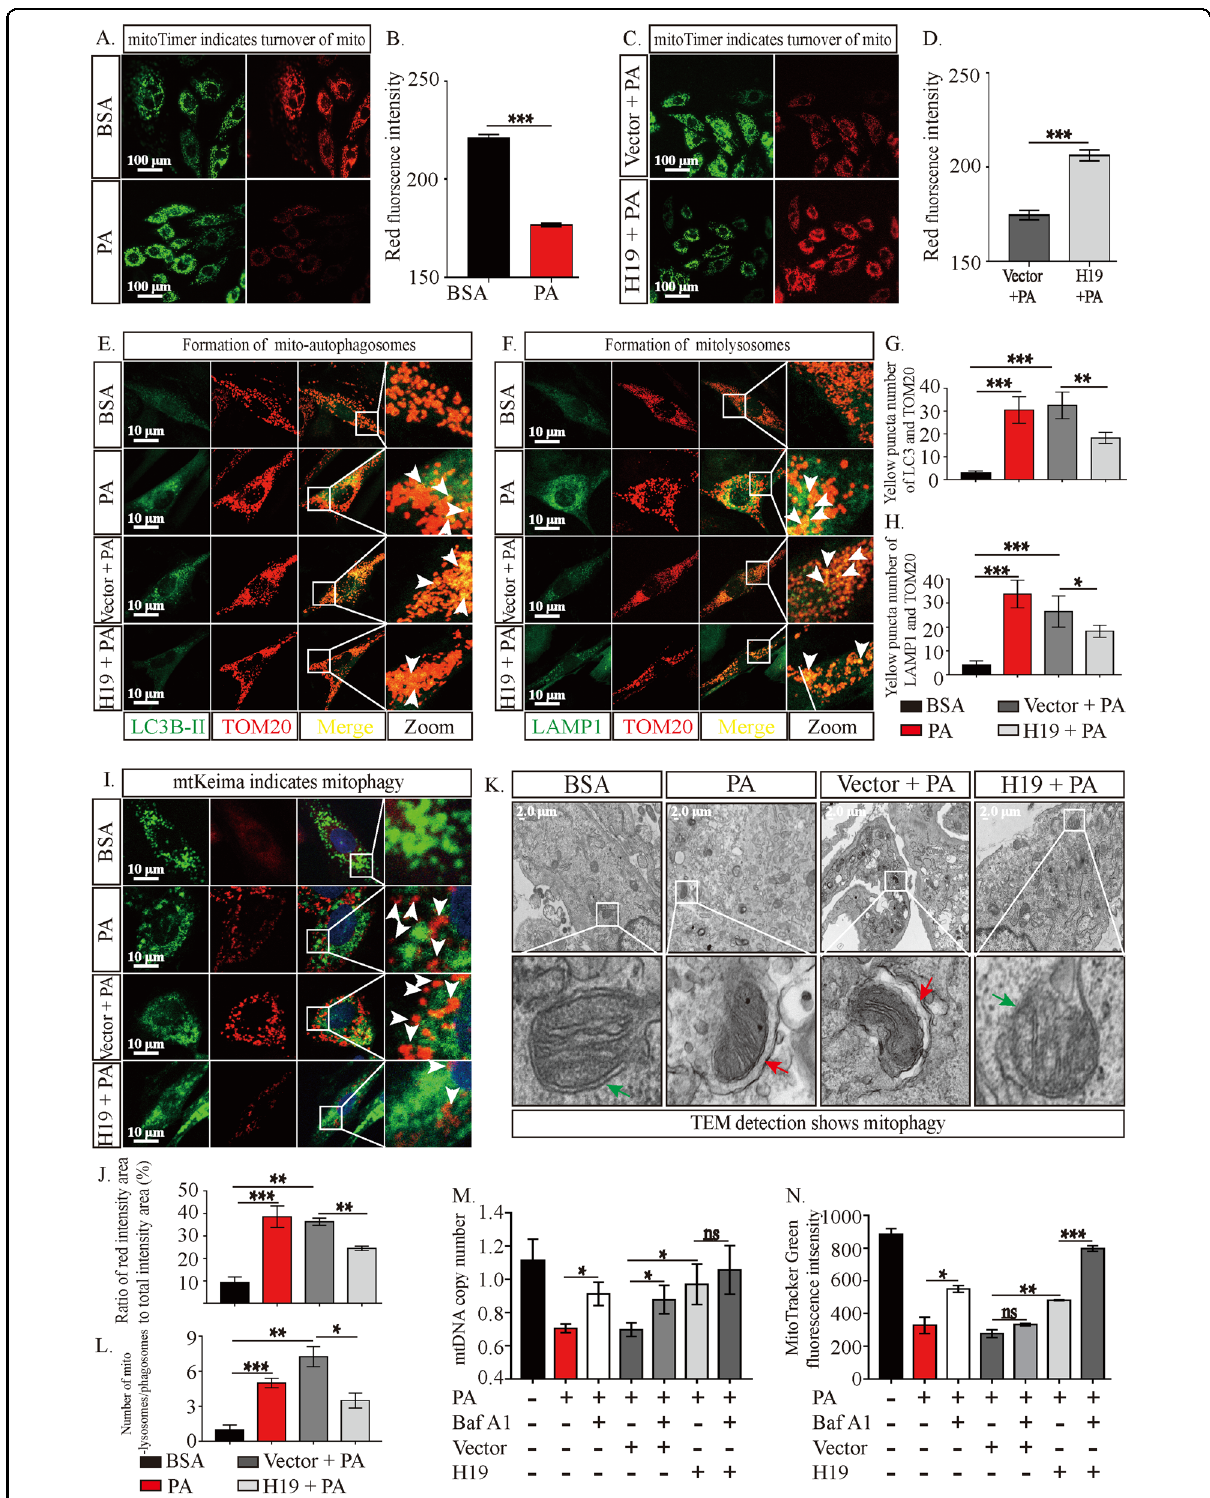
Fig. 3 (See legend on next